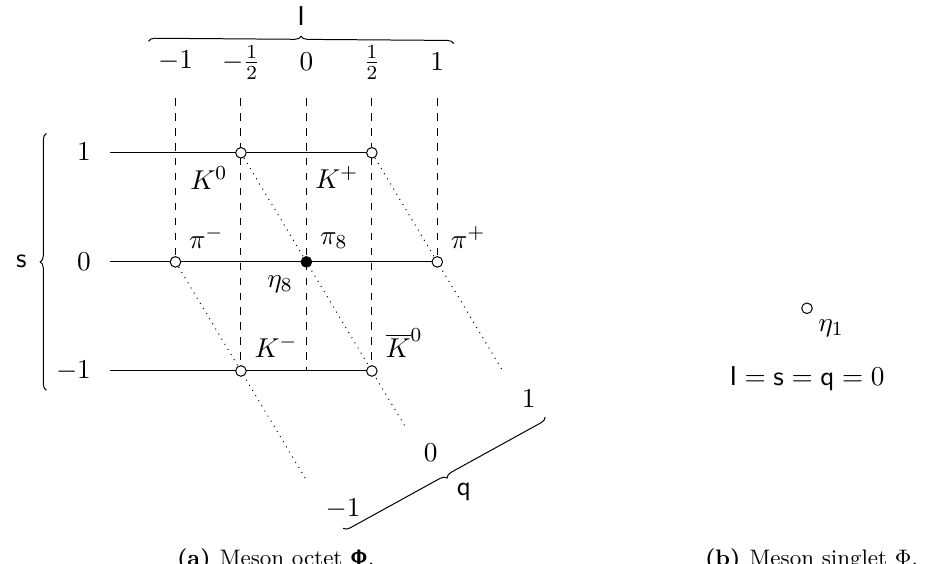
Figure 8. The light pseudoscalar mesons. Panel a shows the isospin I , strangeness s and electric charge q quantum numbers of the light pseudoscalar meson octet, and panel b shows the quantum numbers of the singlet. The three unflavoured mesons ( π eigenstates ( π 0 , η , and η 0